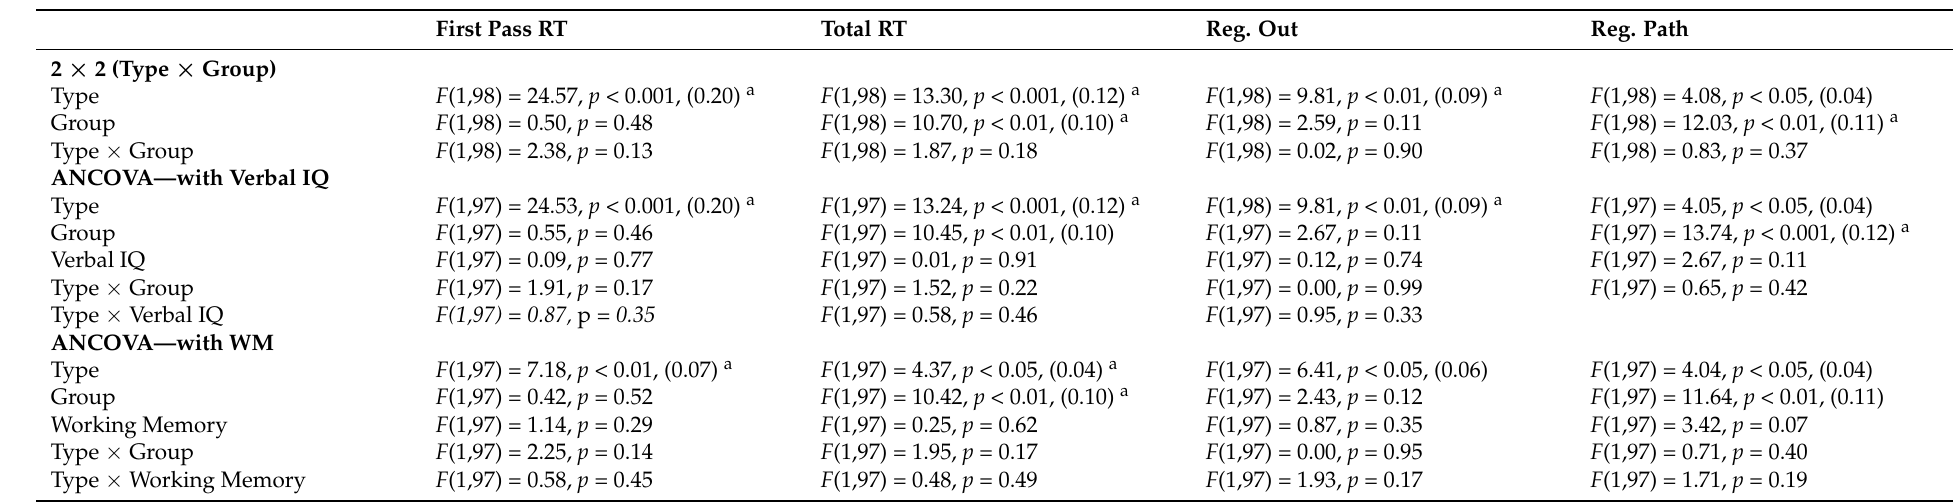
Table 7. Mixed ANCOVA analysis for eye movement measures for the relative